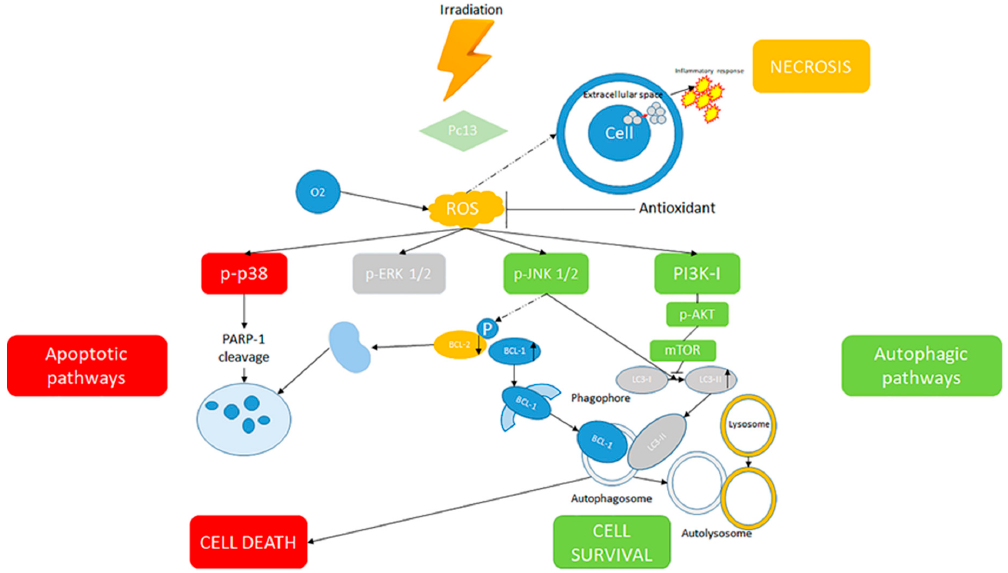
Figure 3. Mechanisms of cell death, survival and necrosis from irradiation.